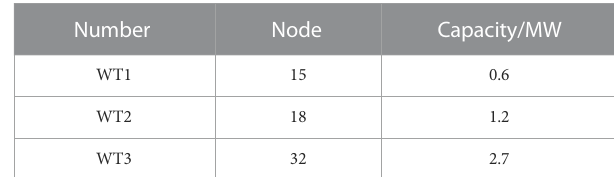
TABLE 1 Parameters of dispersed wind